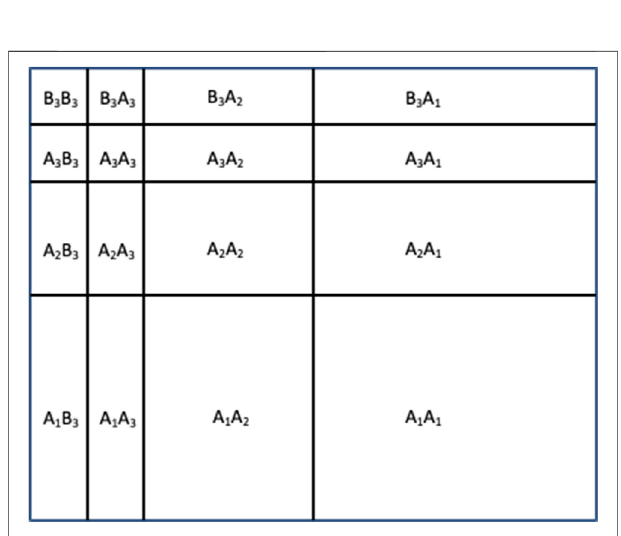
FIGURE7| Multi-level wavelet decomposition ofimage using the3-level L-pyramid wavelet decomposition as proposed in Ansari and Gupta (2017) Notations: (A) denotes Highpass fi ltering and (B) denotes lowpass fi ltering.